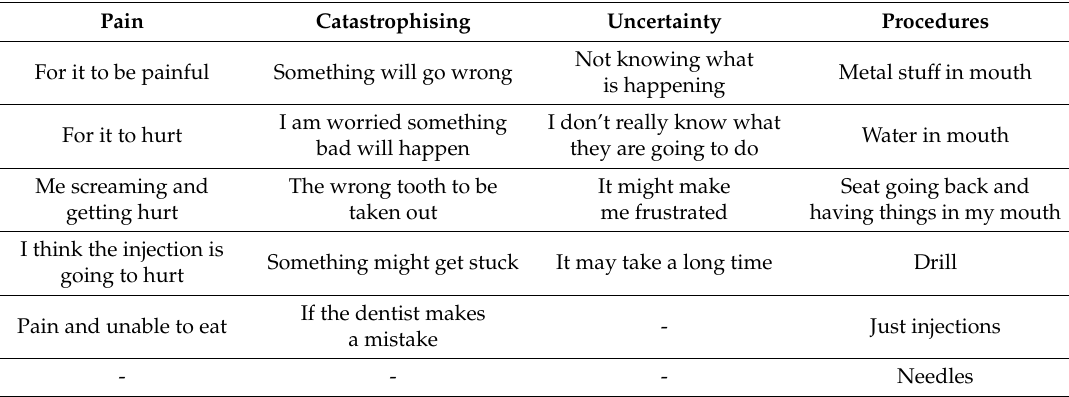
Table 2. Examples of things children reported being worried about, within four